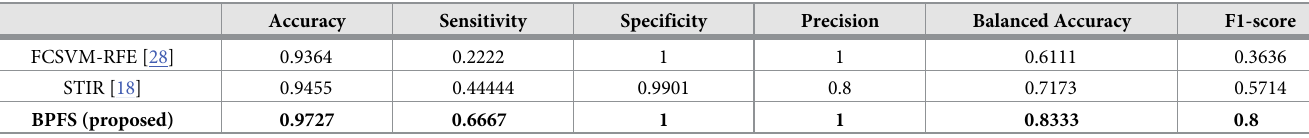
Table 4. Classification effectiveness analysis on the PRAD cancer dataset.